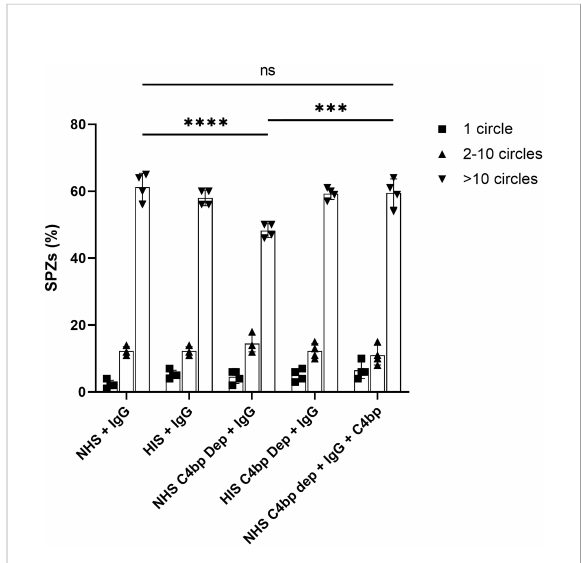
FIGURE 6 C4bp enhances SPZ resistance to malaria hyperimmune IgG -mediated complement activity. Salivary gland SPZs were pre- incubated with NHS or NHS D C4bp (C4bp-depleted NHS), both in the presence of hyperimmune IgG, NHS D C4bp supplemented with physiological level of C4bp in addition to hyperimmune IgG, HIS or HIS D C4bp, both in the presence of hyperimmune IgG and subjected to a gliding motility assay. The number of fl uorescent circles produced by each SPZ was counted for a total of 100 SPZ per test condition and the percentages of SPZs with 1, 2-10